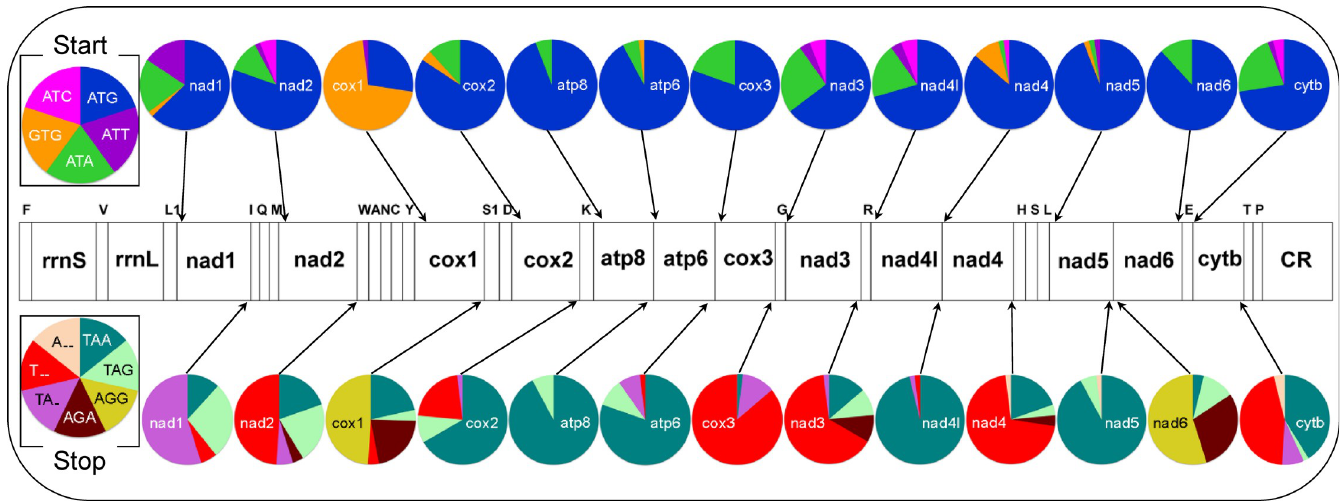
Fig 2. Frequency of start and stop codons for 13 protein-coding genes in the 52 Testudines mitogenomes.